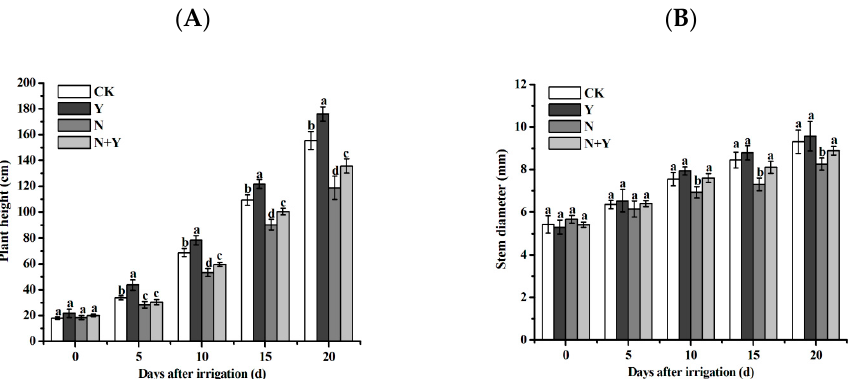
Figure 1. Effects of different treatments on the growth indices of the cucumbers at different time points. ( A ) Plant height; ( B ) stem diameter. Different treatments: CK (control), seedlings were irrigated with a normal nutrient solution; Y, control + B. subtilis K424; N, four-strength control; N + Y, four-strength control + B. subtilis K424. Each histogram represents the mean ± SE of three independent biological experiments ( n = 3). Different letters above the bars indicate statistically significant differences by Duncan’s test ( p <